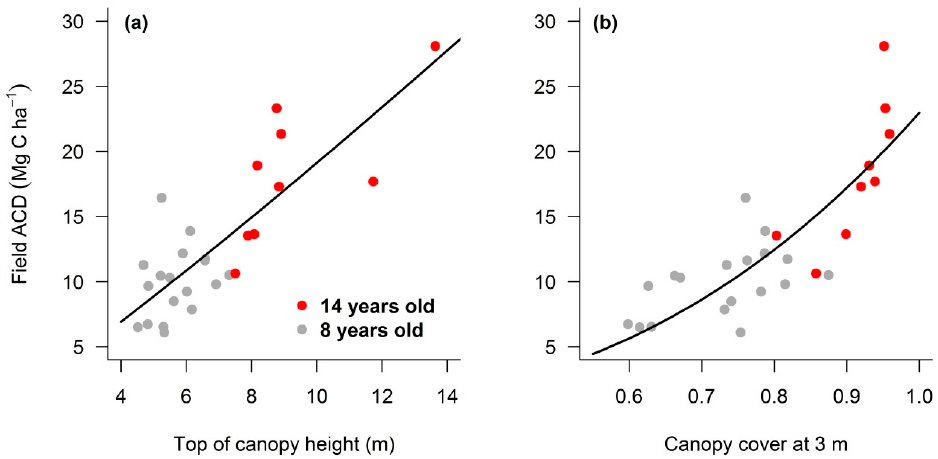
Figure 5. Relationship between aboveground carbon density (ACD) and ( a ) top-of-canopy-height (TCH), and ( b ) canopy cover (CC) at 3 m height per plot for 8-year-old and 14-year-old plantations.